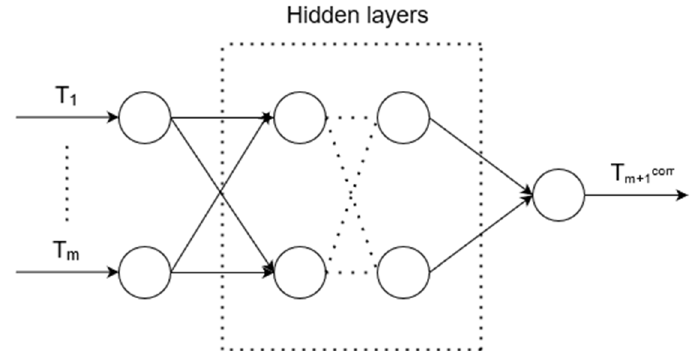
Figure 7. Artificial neural network structure for error correction, where T 1 , ..., T m are input data representing time-series data from the brazing process, i.e., the temperature of one of the brazed elements, and T m+1corr is the output value, which is a corrected measurement.